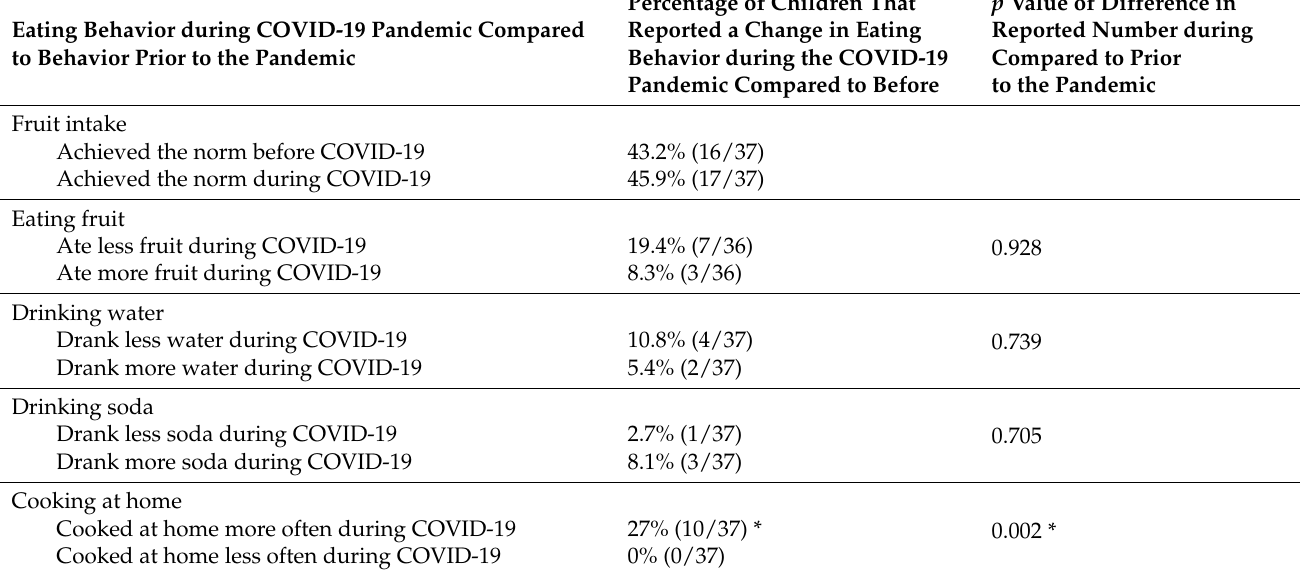
Table 4. Reported eating behavior of children with celiac disease (CD) before and during the COVID-19